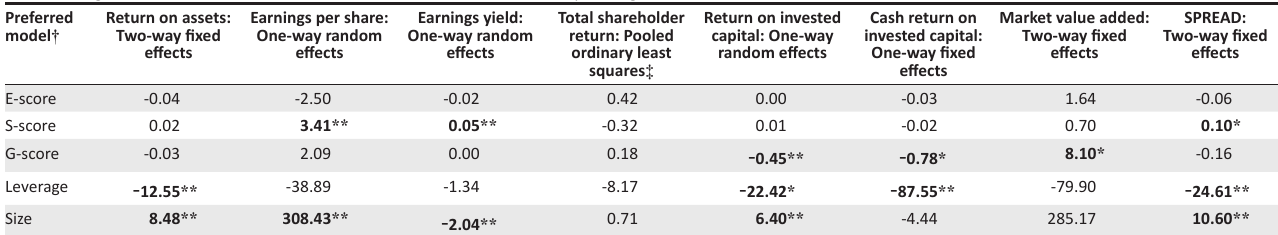
TABLE 5: Regression results for the individual environmental, social and corporate governance disclosure scores for the consumer services sector. Preferred model †